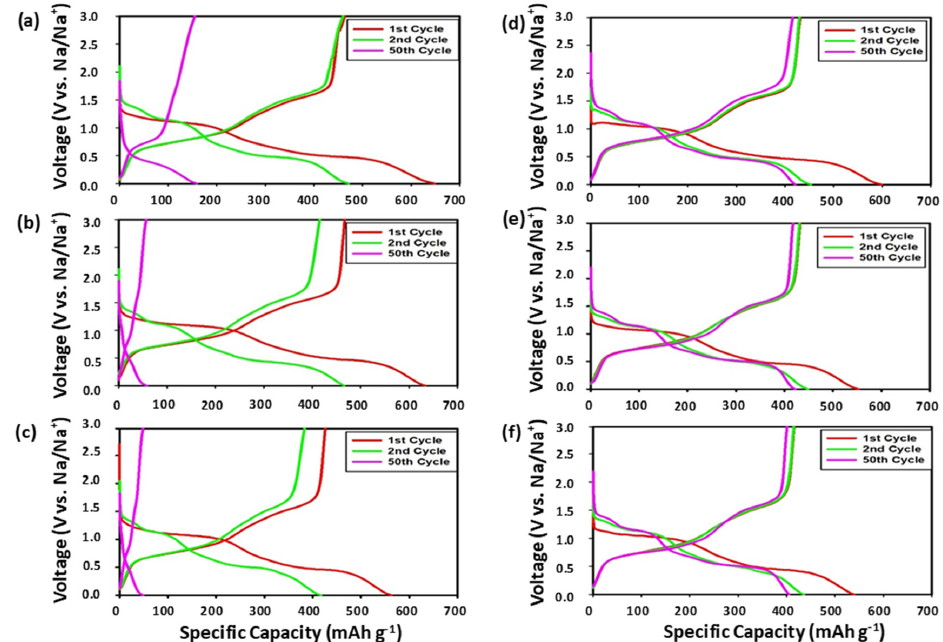
Figure 3. Voltage profiles of SbTe-C20 electrodes containing ( a – c ) 0%, 2%, and 5% FEC (respectively) and the PVDF binder, and ( d – f ) 0%, 2%, and 5% FEC (respectively) and the PAA binder.